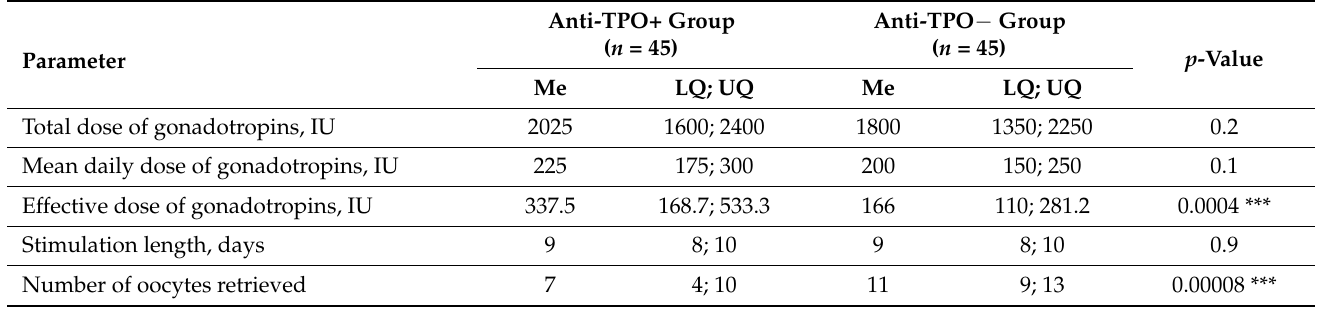
Table 3. Indicators of ovarian stimulation efficiency in groups